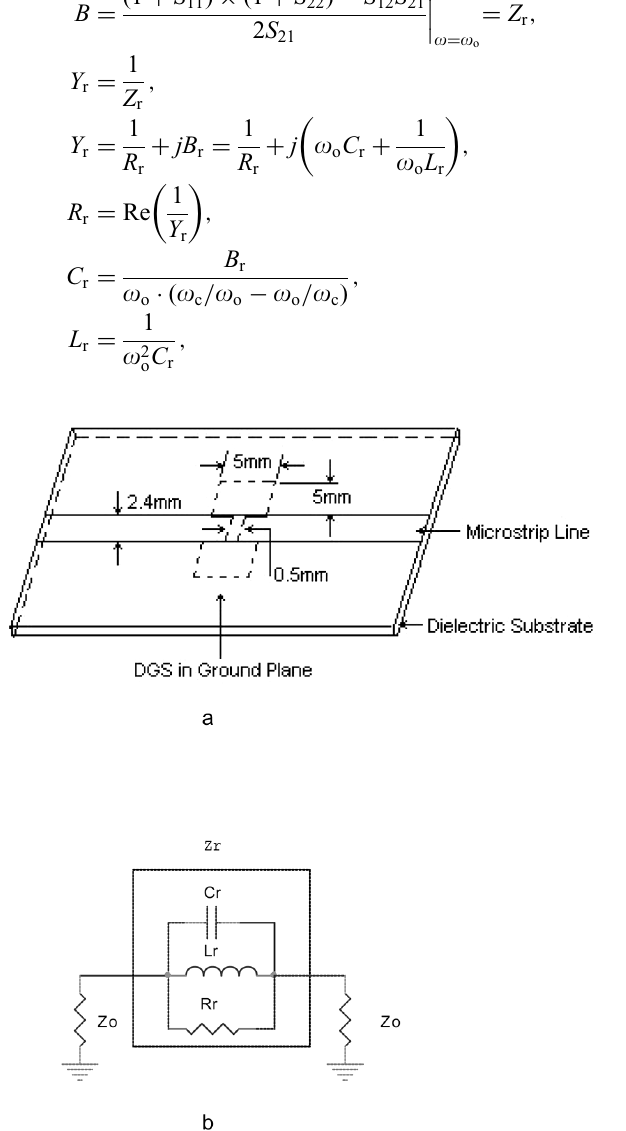
FIGURE 1 Configuration of a microstrip line with DGS and its equivalent circuit: (a) configuration of a microstrip line with DGS (dielectric substrate: e r ¼ 2.22, thickness ¼ 30mils); (b) equivalent circuit of a microstrip line with